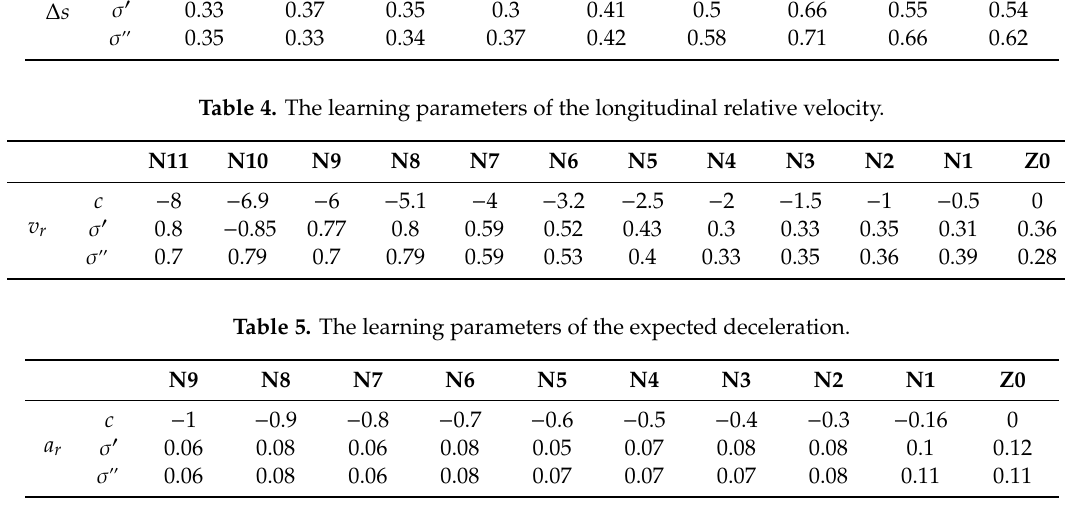
Table 3. The learning parameters of the longitudinal relative distance.